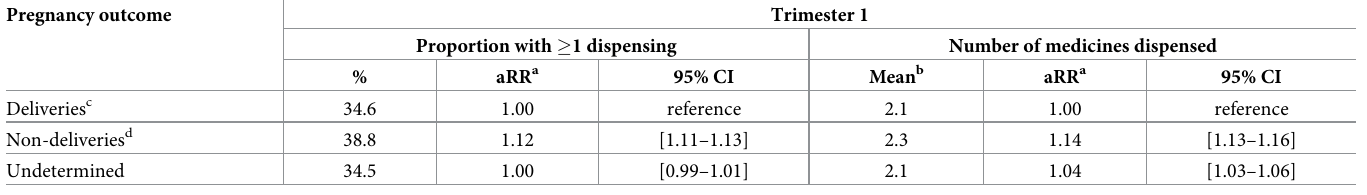
Table 2. Non-supplement dispensing in Trimester 1, by grouped pregnancy